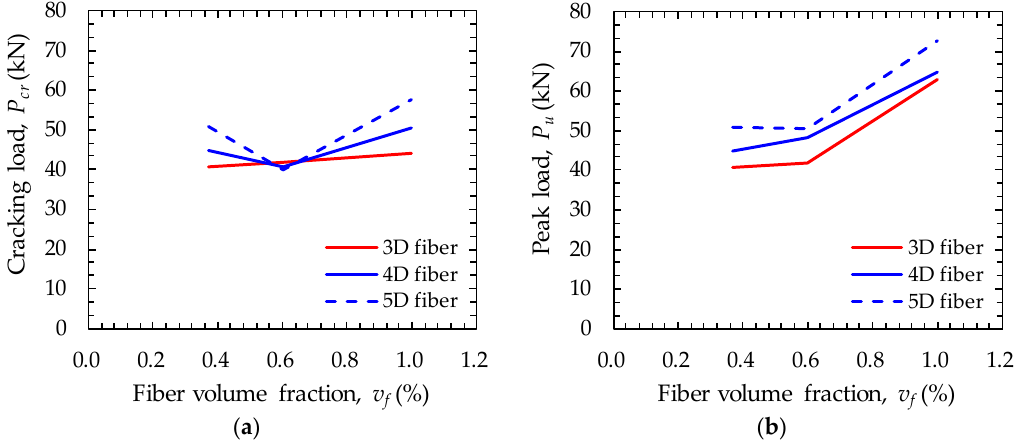
Figure 8. Summary of ( a ) cracking load and ( b ) peak load.